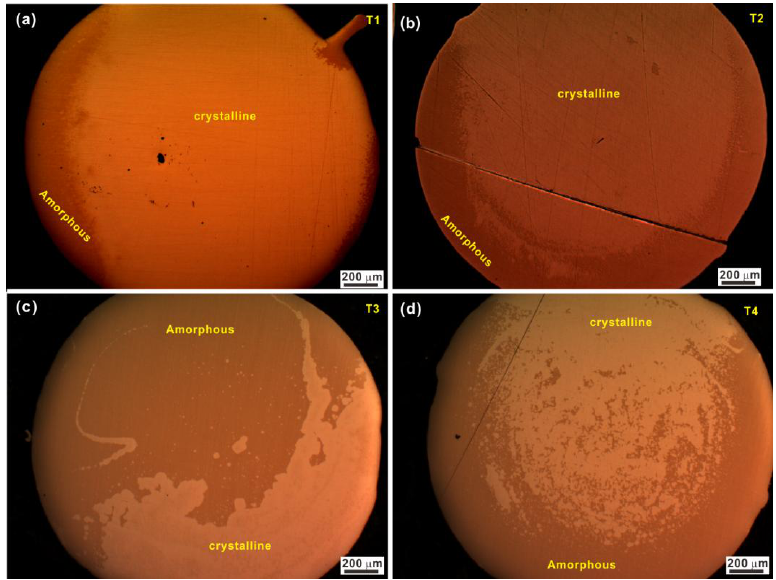
Figure 2. Optical microscope (OM) images of the as-cast ( a ) T1, ( b ) T2, ( c ) T3, and ( d ) T4 rods with a diameter of 2 mm. Metals 2018 , 8 , x FOR PEER REVIEW